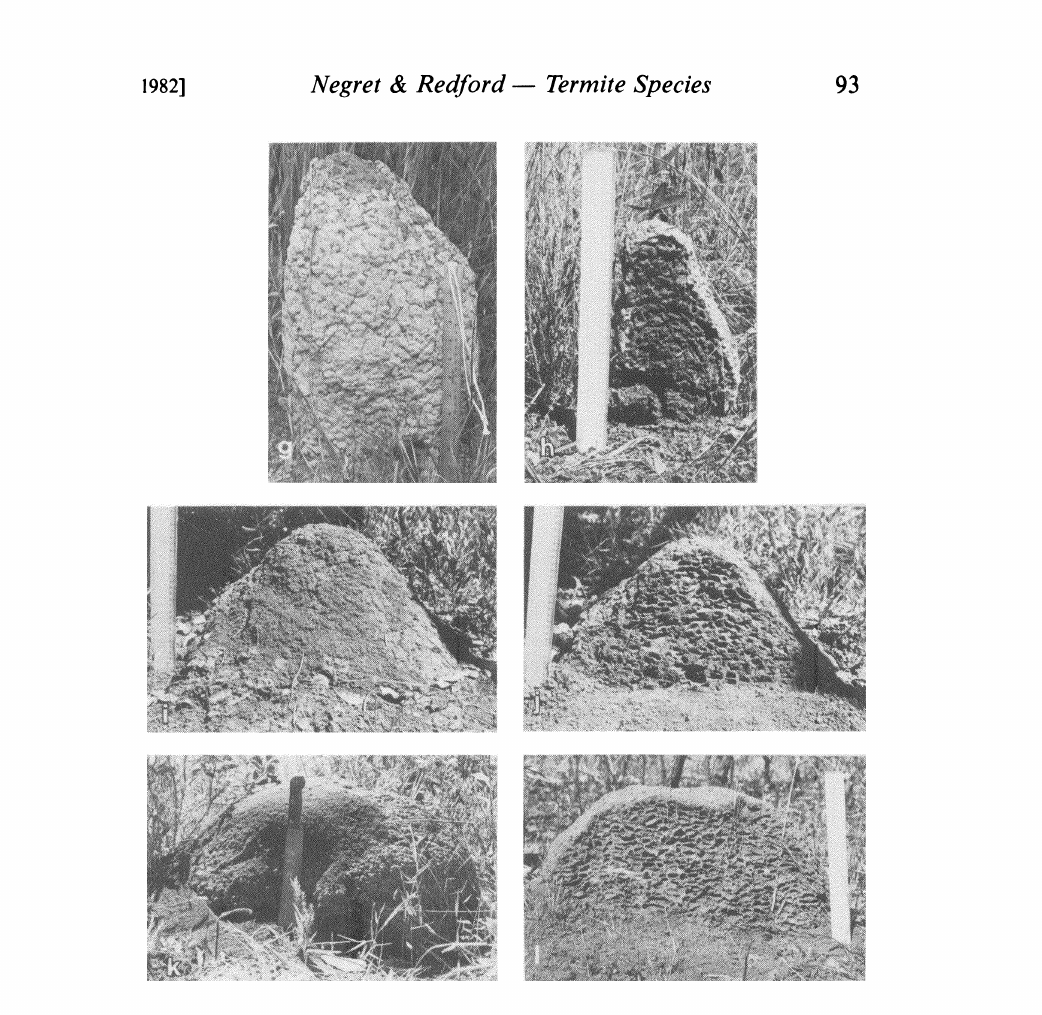
Figure 4. Mounds of the termite species studied; external view and longitudinal section: g and h, Velocitermes paucipilis; and j, Grigiotermes metoecus; k and 1, Procornitermes